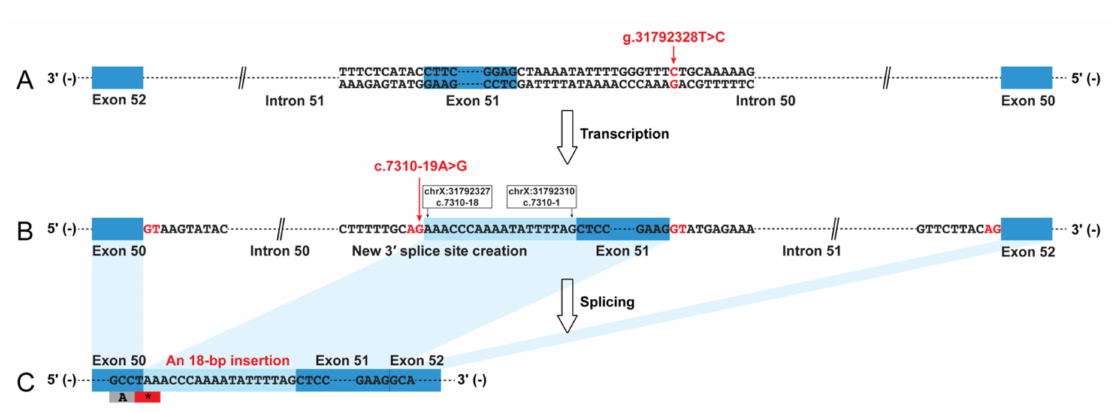
Figure 1. Graphic representation of the non-canonical splicing event caused by a de novo and novel genomic intronic variant in the dystrophin ( DMD ) gene. The intronic variant c.7310-19A > G in intron 50 created a new 3 (cid:48) splice site that was stronger than the natural acceptor site of exon 51. This caused the inclusion of an 18 bp sequences into the mature transcript, which was predicted to create a premature termination codon. ( A ) Patient genome (NC_000023.10); ( B ) dystrophin pre-mRNA; ( C ) dystrophin mRNA